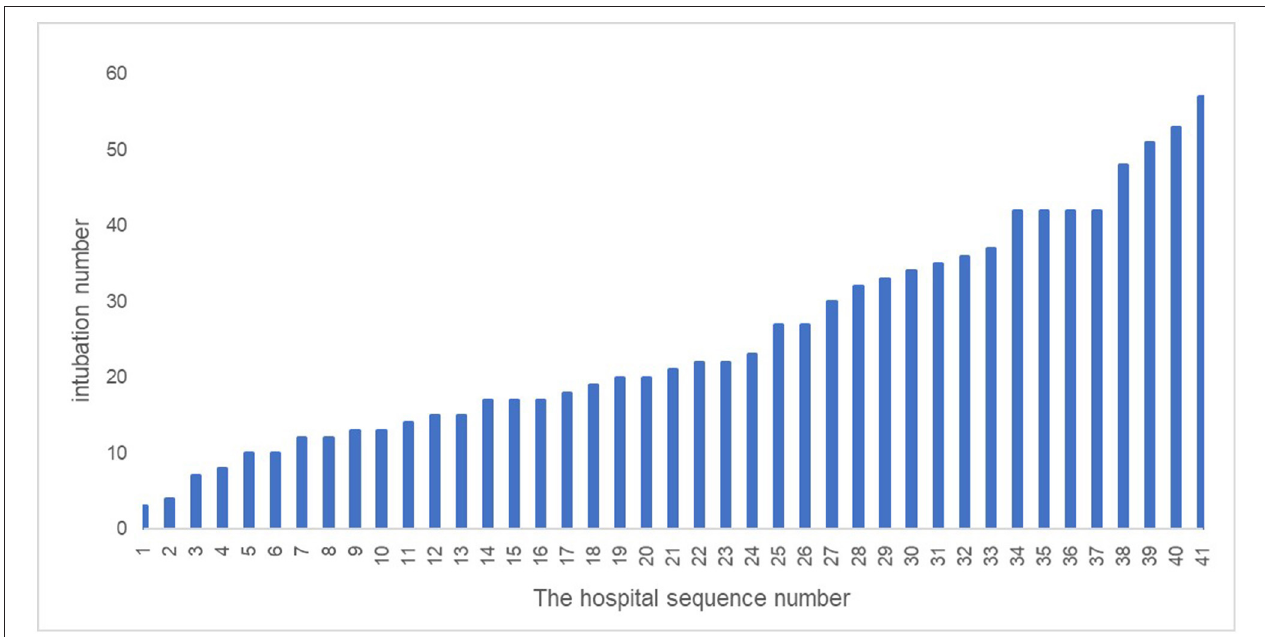
FIGURE 3 | Emergency department (ED) intubation frequency in each hospital in March 2021.